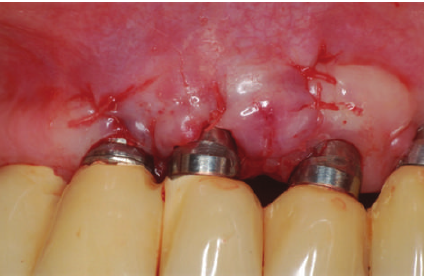
Figure 13: Postoperative absence of peri-implant pocket in 6 months.